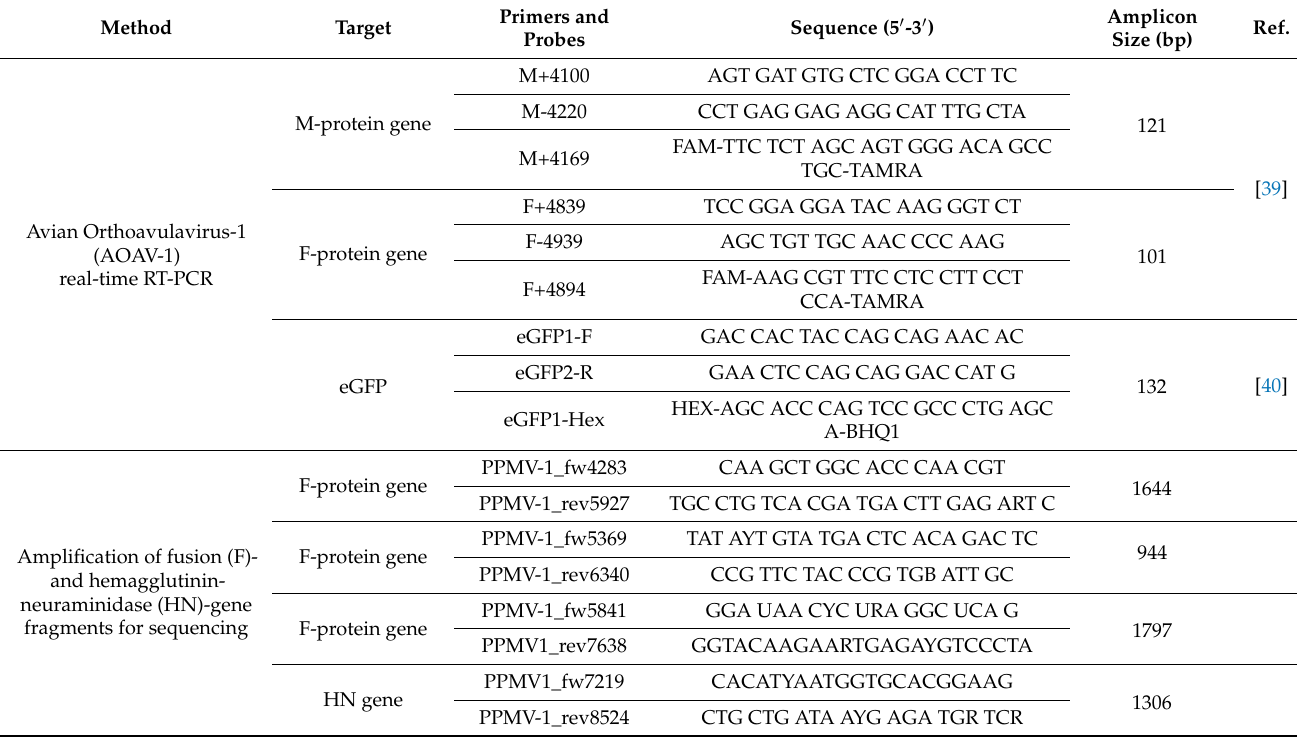
Table 1. Primers and probes for the AOAV-1 real-time RT-PCR assay used in this